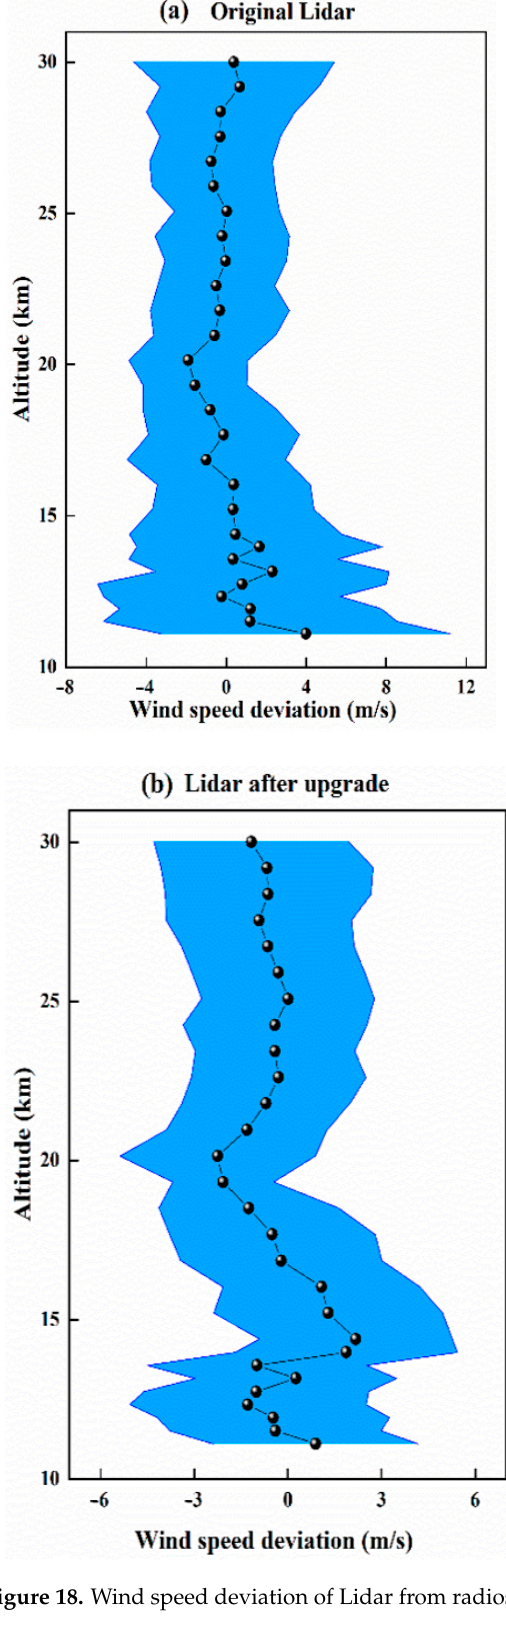
Figure 18. Wind speed deviation of Lidar from radiosondes. ( a ) Original ( b ) Upgraded.